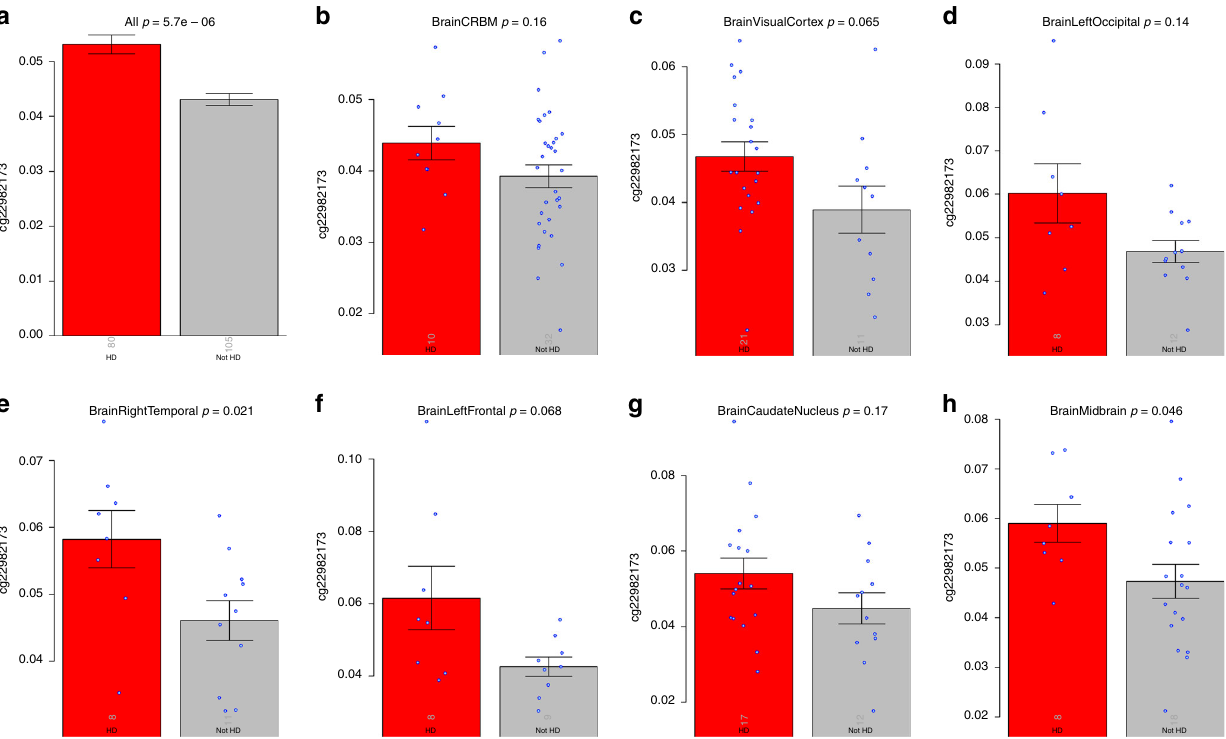
Fig. 5 Human HTT methylation in different brain regions. The fi gure depicts the bar plots for the association of HD disease status with HTT cg22982173 in different brain regions ( N = 67 from 26 HD versus 39 control individuals). We used n = 185 brain tissues (80 HD versus 105 controls) from seven brain regions: a bar plot based on all the seven brain regions combined. The results for a remain signi fi cant ( p = 0.015) after adjusting for intra-individual correlations using a linear mixed-effects model. b – h Bar plots for each individual region: cerebellum (CRBM), visual cortex, left occipital, right temporal cortex, left frontal cortex, caudate nucleus, and midbrain, respectively. The blue dots correspond to individual observations that underlie the respective mean values. The y -axis of the bar plots depicts the mean of one standard error. The numbers of individuals per group are reported as gray numbers in each bar. The heading of each panel reports a nominal (unadjusted) two-sided p value (Kruskal – Wallis EWAS hit in all fi ve tissues pro fi led on the custom methylation array (Supplementary Data 1).